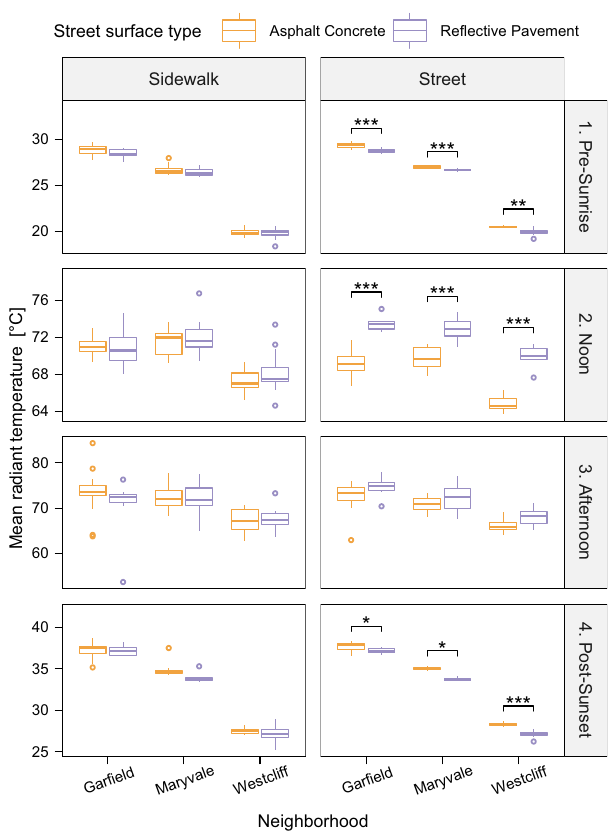
Fig. 5 | Overview ofmean radiant temperature measurements for all areas and times. Average MaRTy-derived mean radiant temperature (Tmrt) across all neighborhoods and transects, delineated by positions (on adjacent sidewalk (left) versus on road (right))for asphaltconcrete, AC (orange), and re fl ective pavement, RP(purple)inbox-whiskerplots.Centerline=median;boxlimits=upperandlower quartiles; whiskers=1.5x interquartile range; points=outliers. Signi fi cance tests denote the difference between the RP and AC surface (*** p <0.001, ** p <0.01, * p <0.05). Source data are provided as a Source Data fi